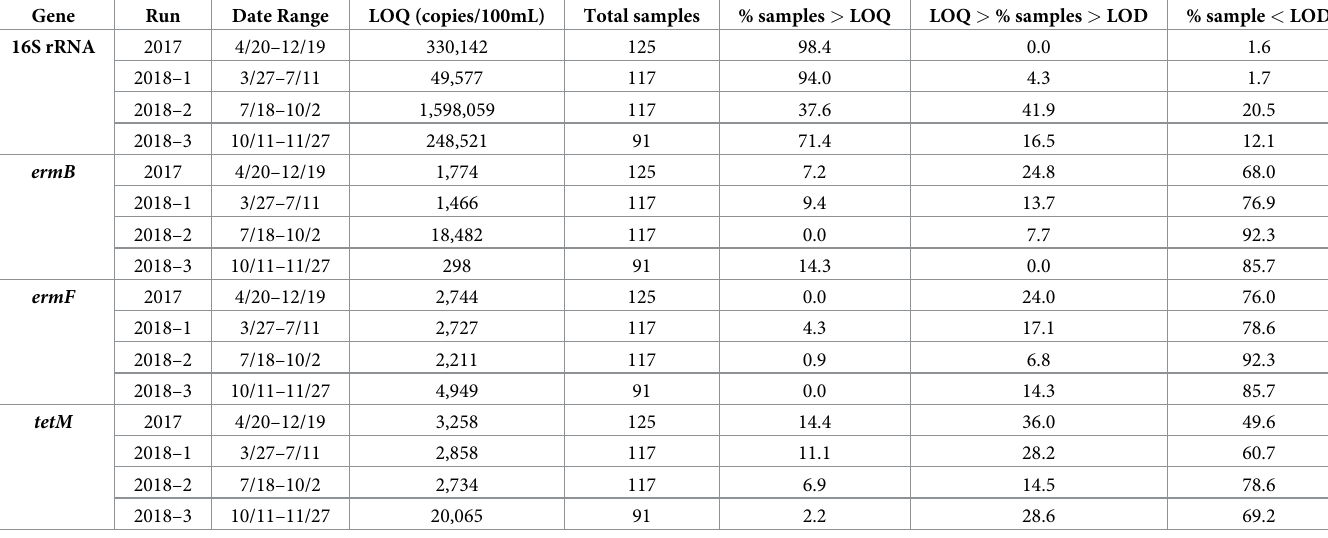
Table 2. LOQ and LOD for the four selected genes in the standard curve method.